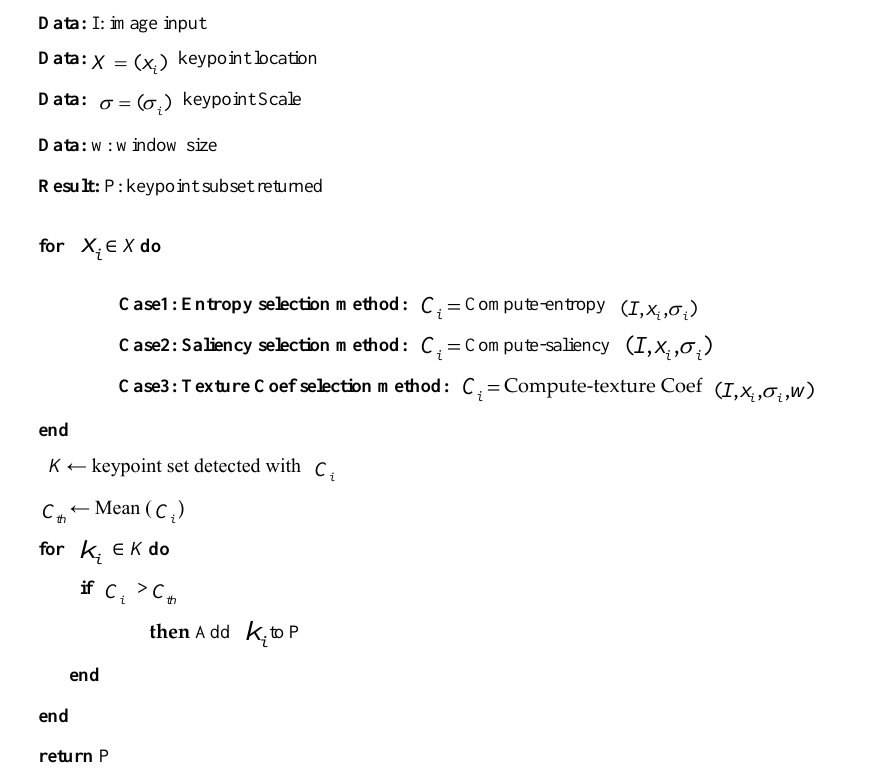
Figure 2. Pseudocode of the keypoint selection algorithm (Algorithm